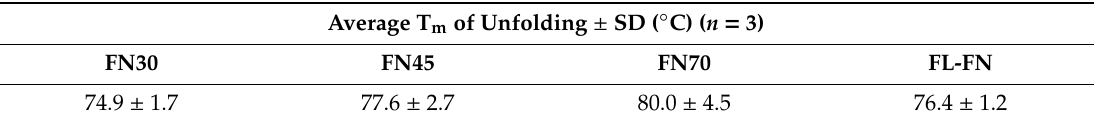
Table 1. Analysis of stability of FN fragments by thermal shift